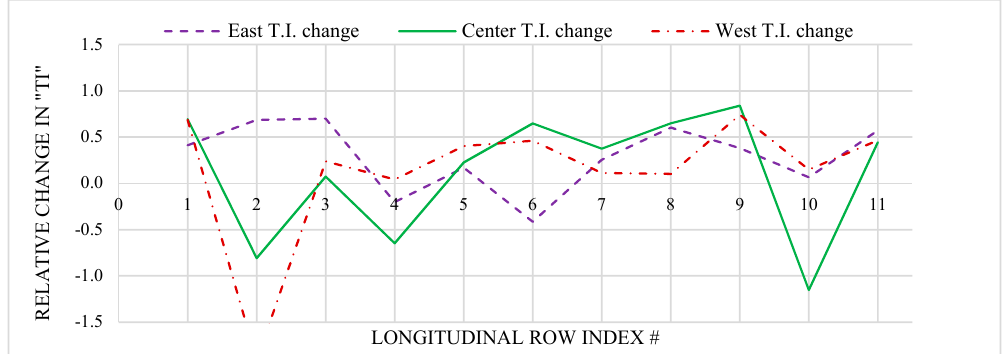
Figure 13. Relative change in TI between heated and unheated manikins.